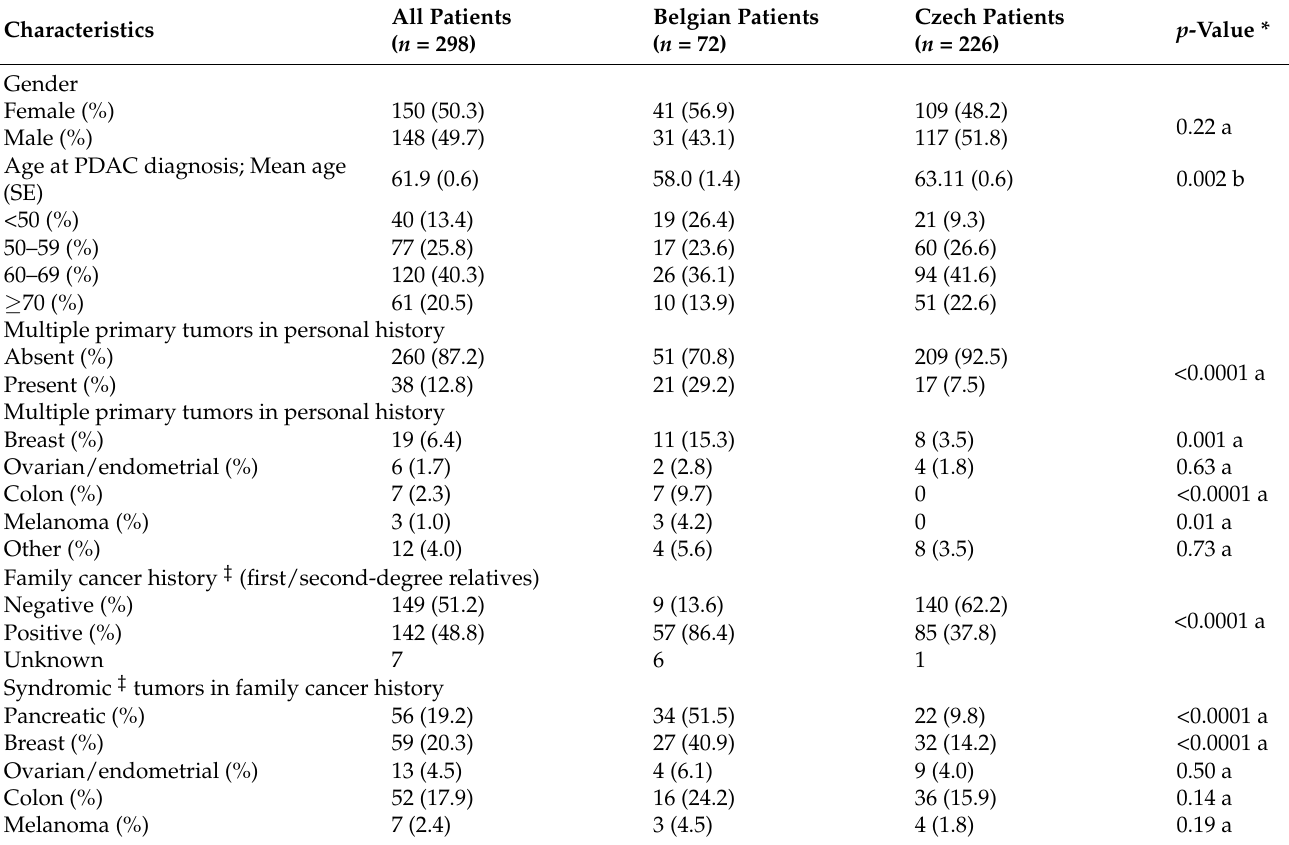
Table 1. Clinical characteristics of analyzed PDAC